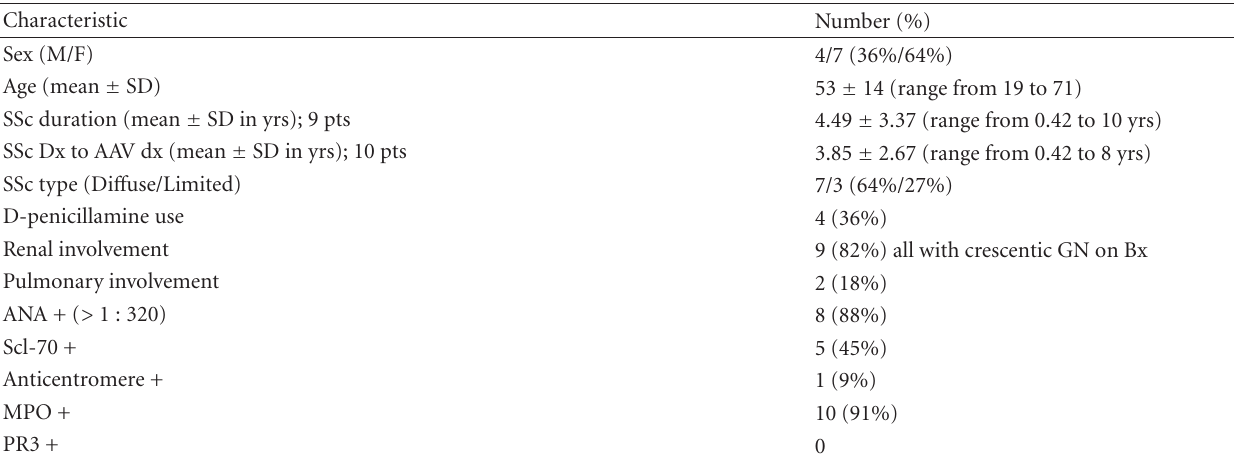
Table 4: Characteristics of eleven cases of AAV in